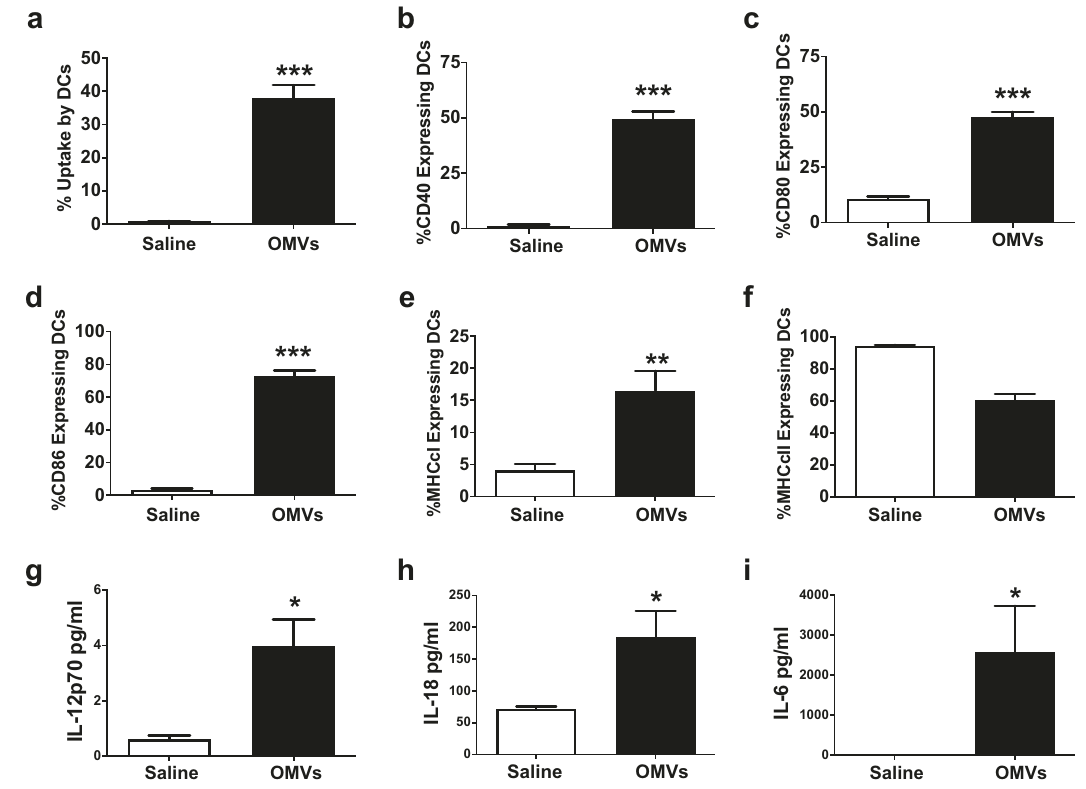
Fig. 7 OMVs activate dendritic cells in vivo. Mice ( n = 5 per group) were injected intraperitoneally with 10 μ g CFSE-labeled OMVs or saline and cellular exudate was harvested 6 h later by peritoneal lavage. a The percentage of DCs harboring OMVs and expressing b CD40, c CD80, d CD86, e MCH class I, and f MHC class II was assessed by fl ow cytometry. The levels of cytokines g IL-12p70, h IL-18, and i ) IL-6 present in lavage fl uid were measured by multiplex assay. * p < 0.05, ** p < 0.01, *** p < 0.001 compared to saline by Student ’ s t test. Results are representative of two independent